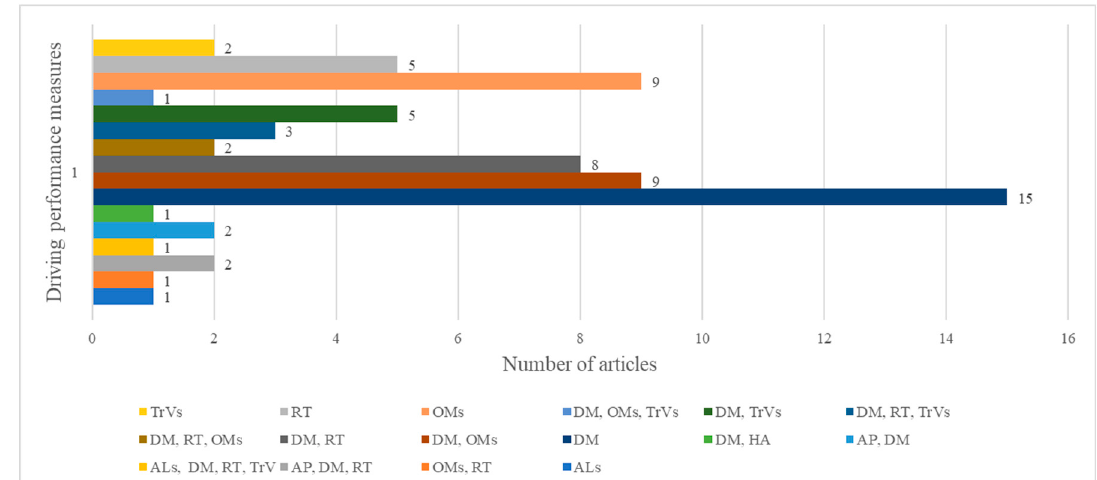
Figure 7. Distribution of papers according to driving performance measure categories (TrVs—traffic violations; DM—driving maintenance; ALs—attention lapses; RT—response time; HA—hazard anticipation; AP—accident probability; and OMs—other measures).